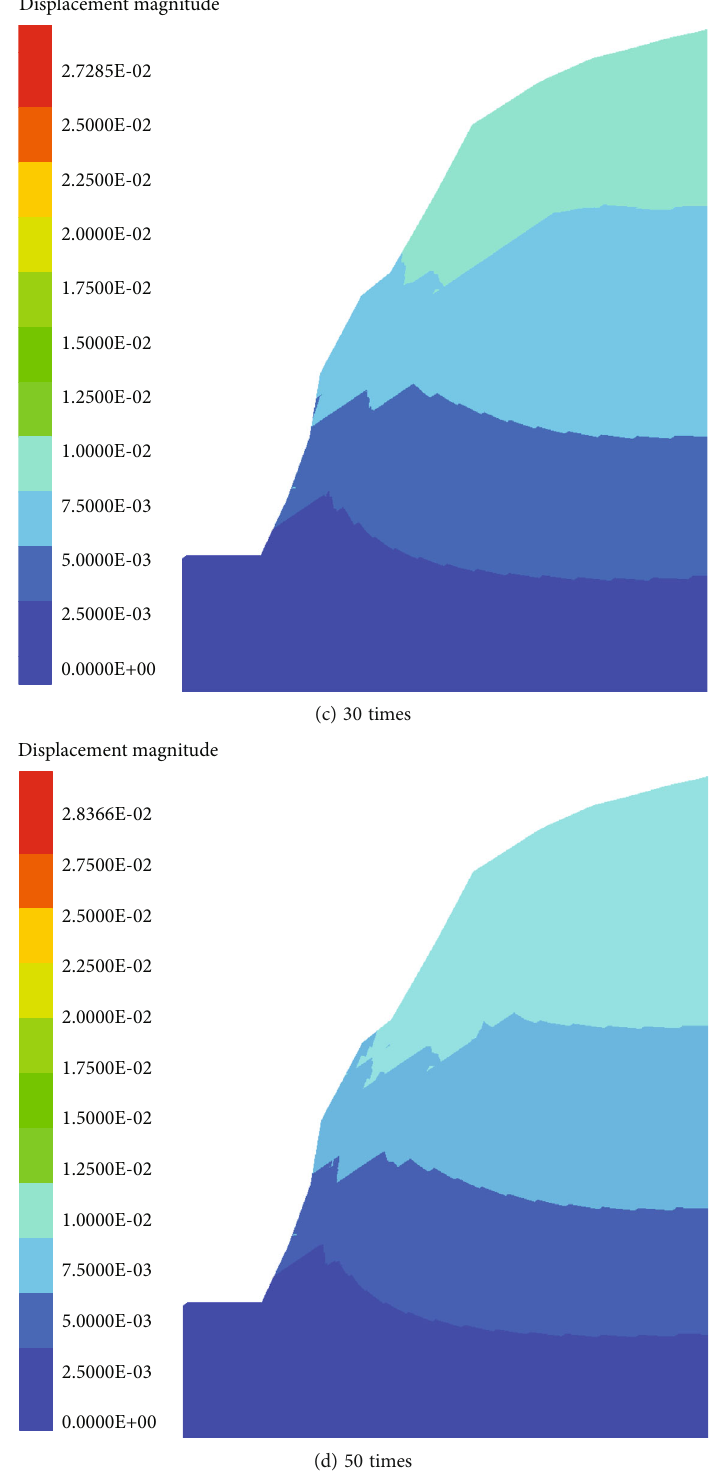
Figure 4: Displacement distribution of the typical rocky